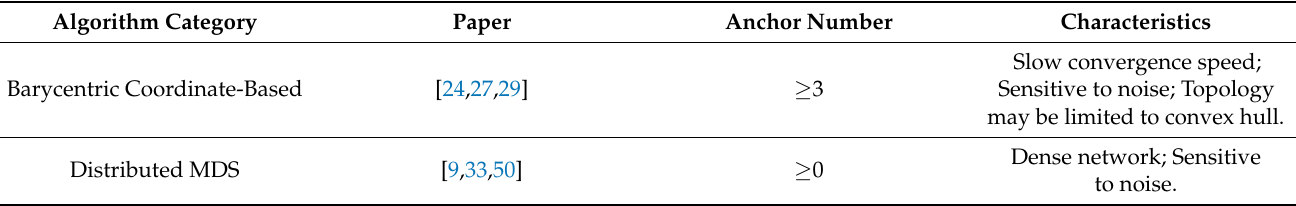
Table 2. Comparison of distributed location algorithms based on distance measurement. Note that s is a parameter set in advance, which may be different in different